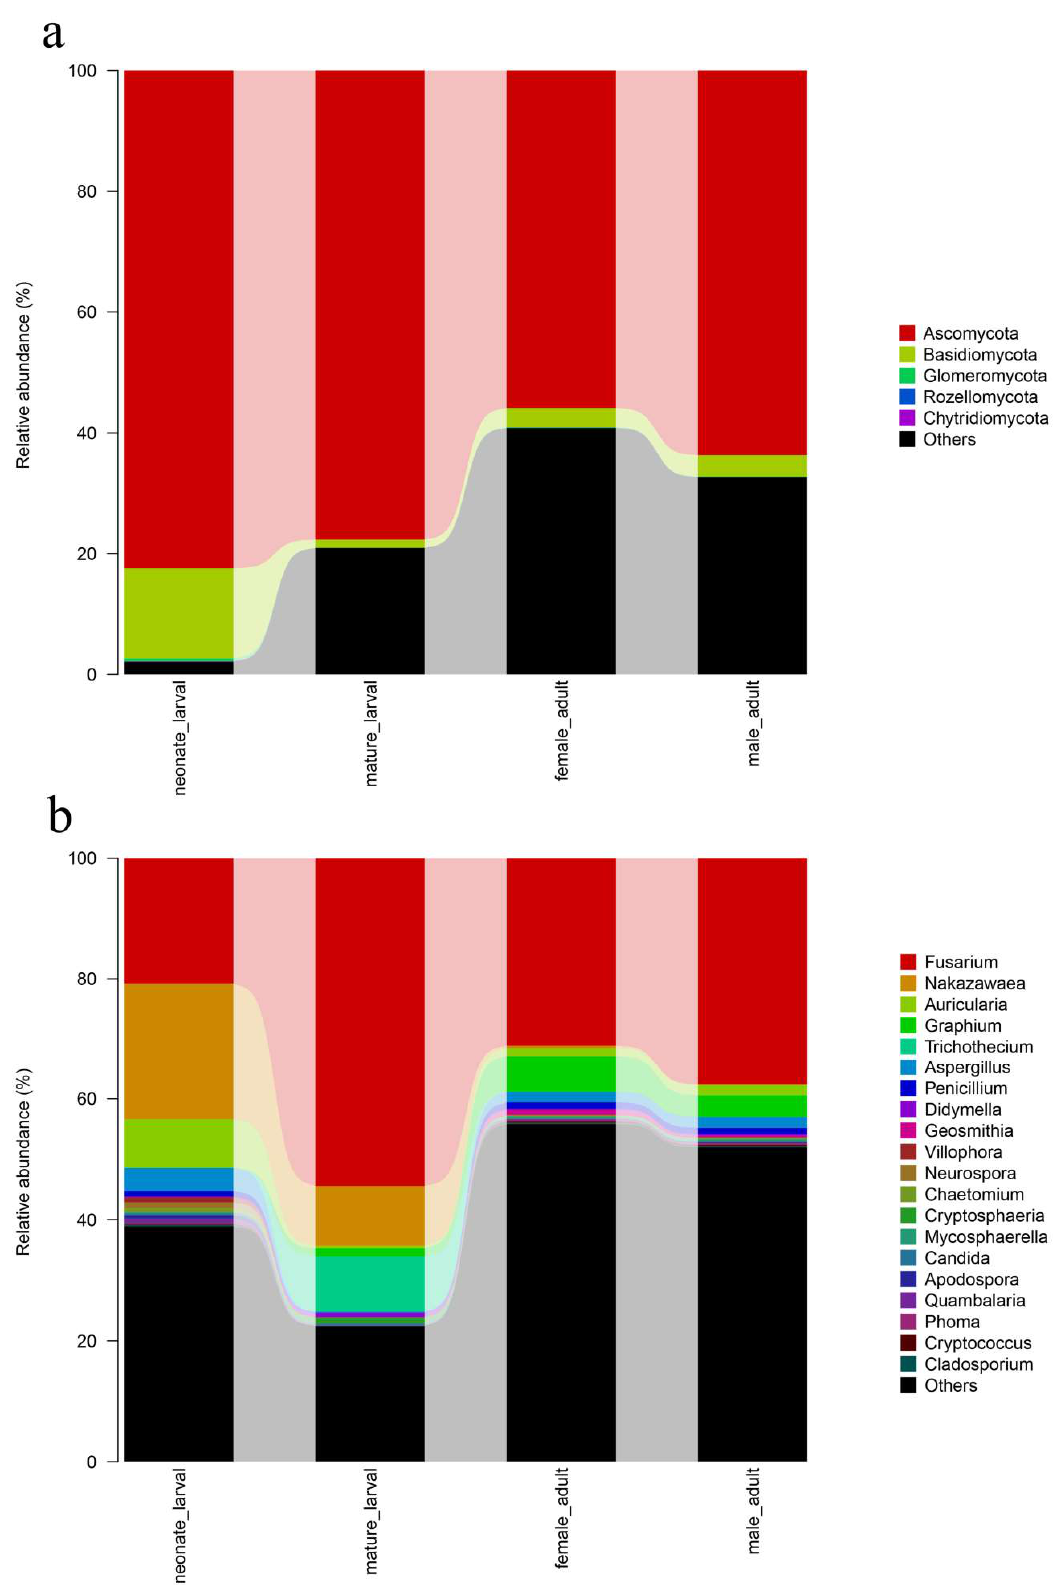
Figure 3. Fungal community structure variation in different development stages of T. klimeschi at the phylum level and the genus level. ( a ) phylum level; ( b ) genus level.